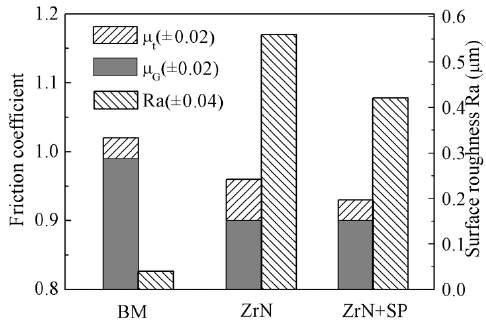
Figure 13. µ t , µ G and the surface roughness ( R a) of different modified specimens.